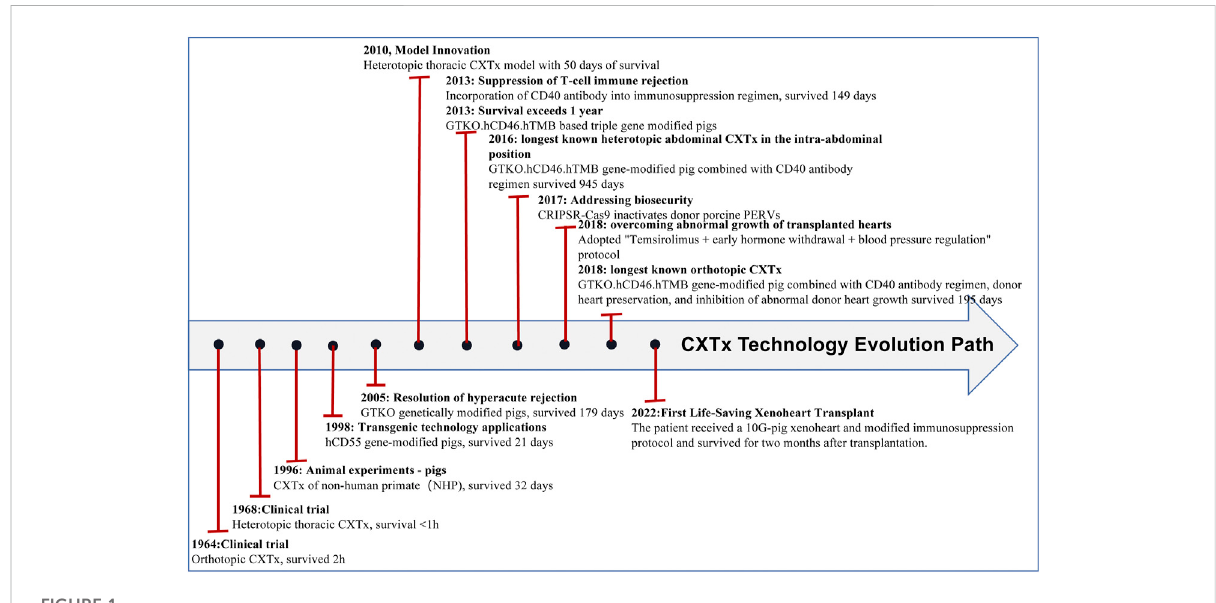
FIGURE 1 CXTx technology evolution path.